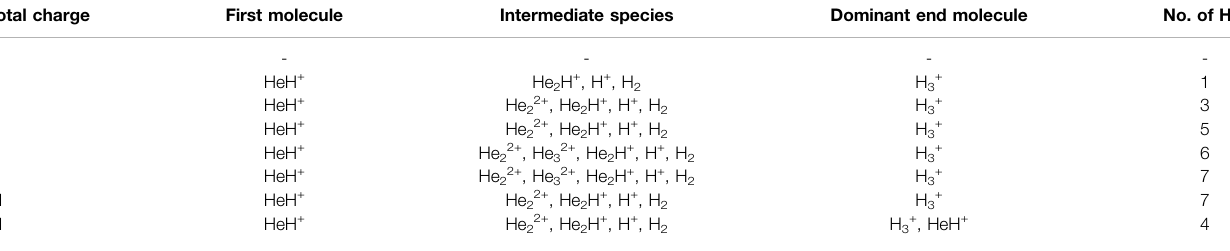
TABLE 2 | AINR simulations with 30 He atoms and 29 H atoms: different entries represent the variation of the total positive charge of the system – by odd numbers. Total charge First